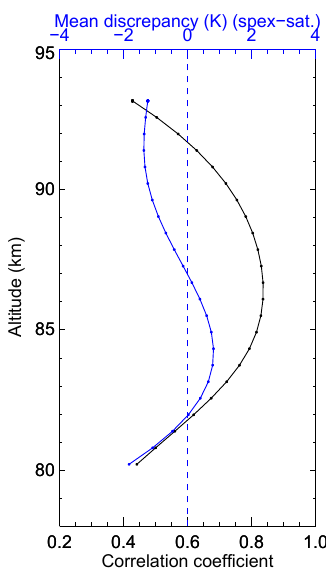
Figure 8. The correlation coefficient and the mean discrepancy be- tween the spectrometer OH temperatures and the SABER tempera- tures when the latter are interpolated to a series of constant density levels. See text for further